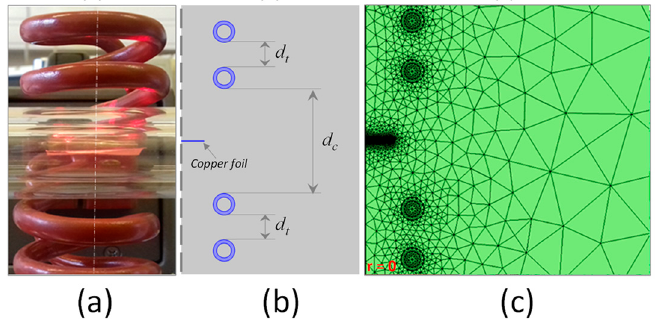
Figure 5. ( a ) Photography of the reactor; ( b ) Object geometry of the induction heating system; ( c ) Finite element mesh of the computational domains with the copper foil in the middle of the coils where water flows (cross section configuration). Fine grid is placed in the areas where strong gradients are expected.